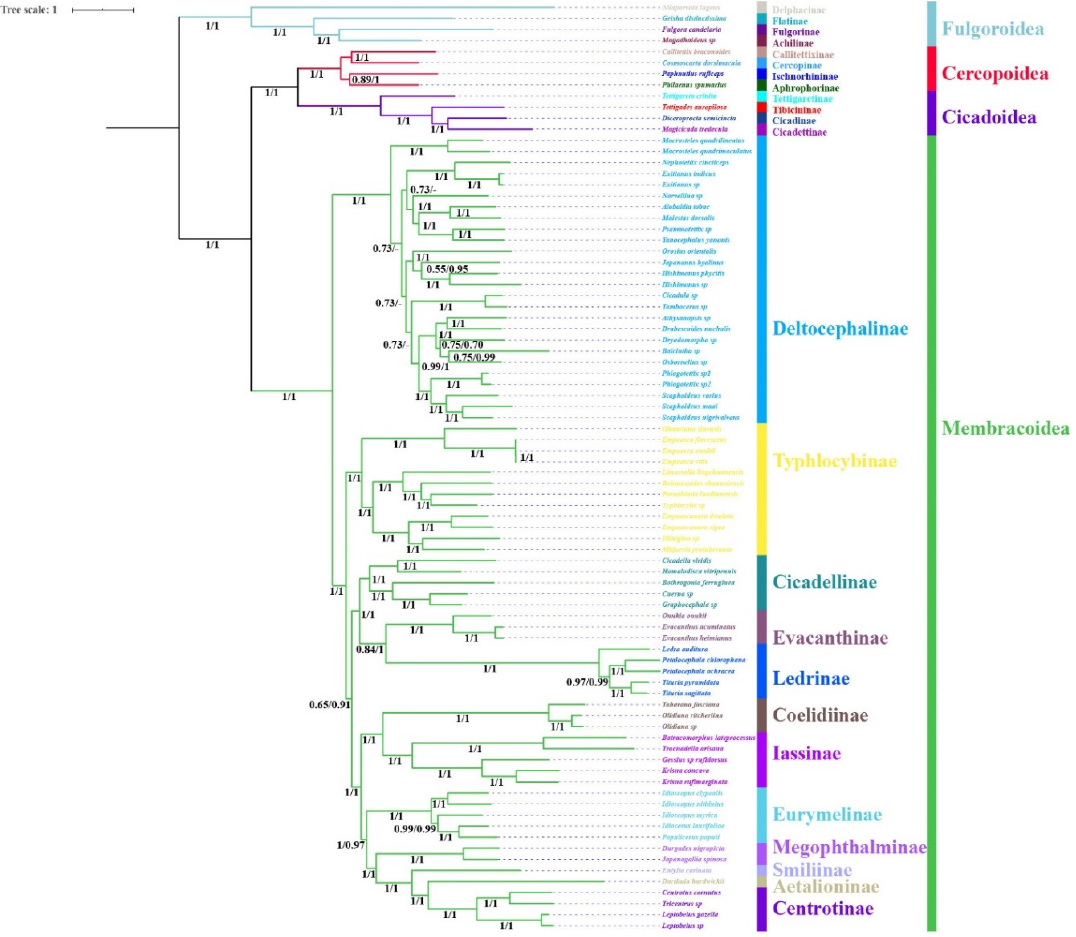
Figure 8. Phylogenetic tree produced using Bayesian inference based on the dataset of P123R / P123. Numerals at nodes are Bayesian posterior probabilities (PP). “-” indicates the clades or species are different in Bayesian inference (BI).